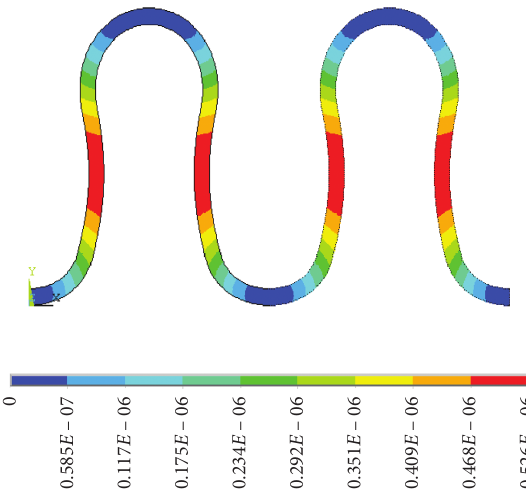
Figure 8: Deformation distribution at air outlet and gas inlet side without considering thermal stress (m).